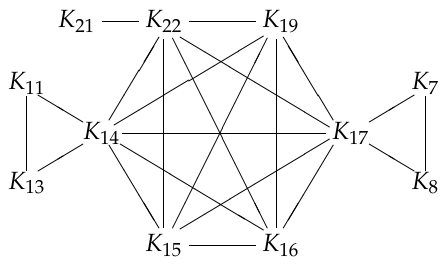
Figure 1. Graph of ( 29,5 ) -arcs with distance